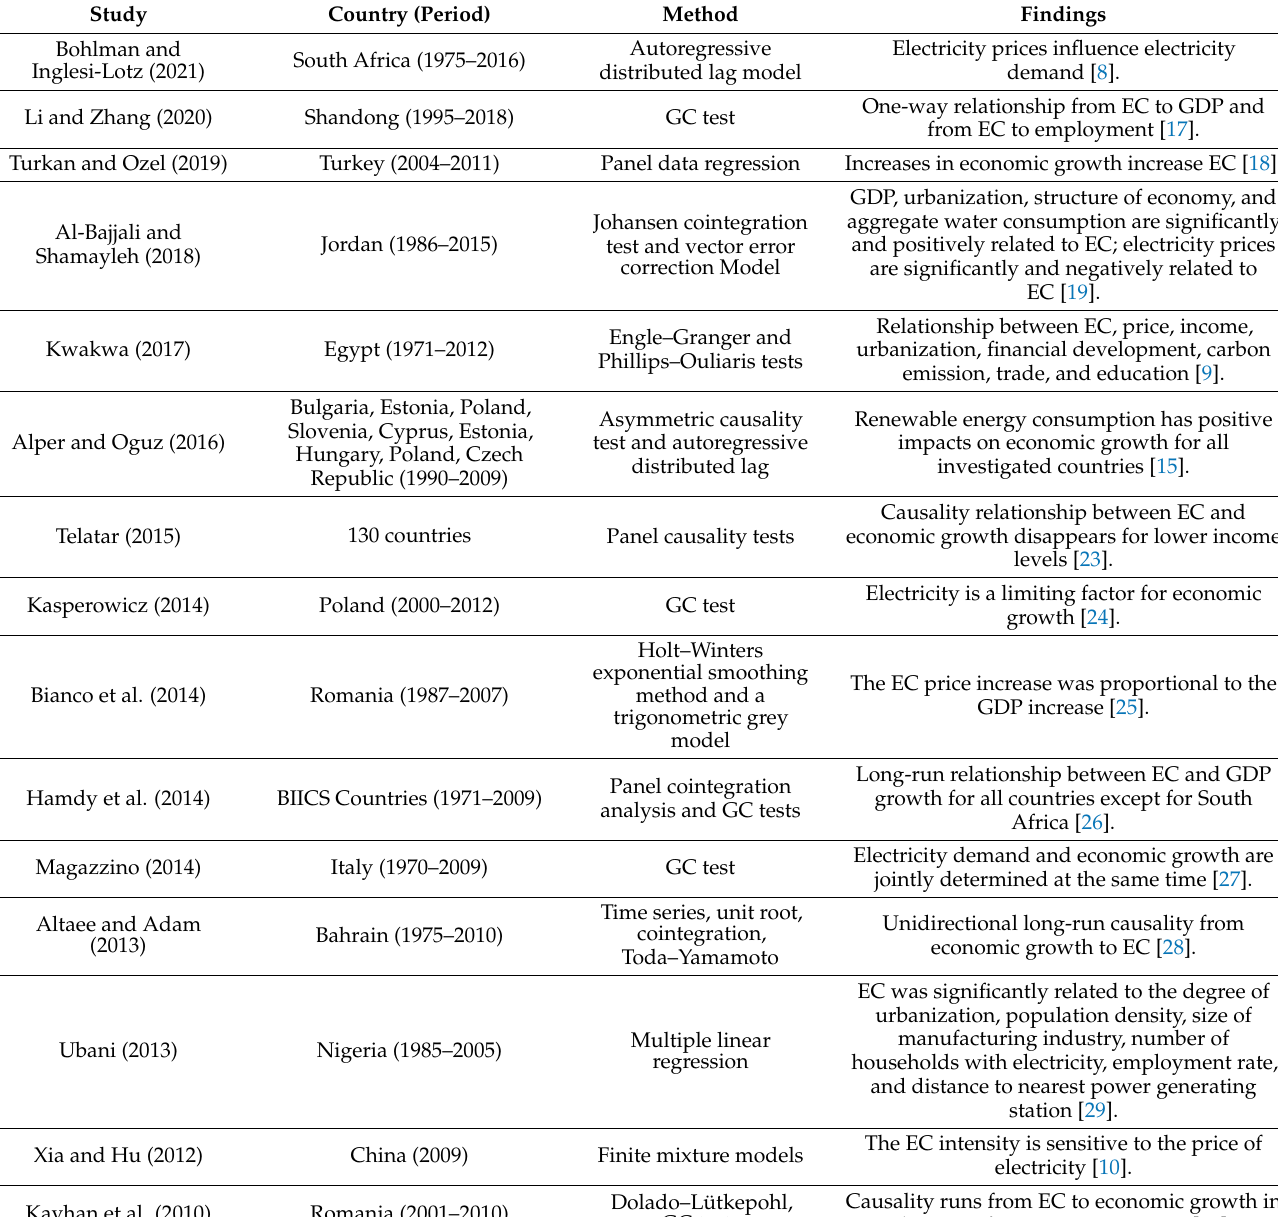
Table 1. Literature review on the relationship between economic, social, demographic factors and electricity